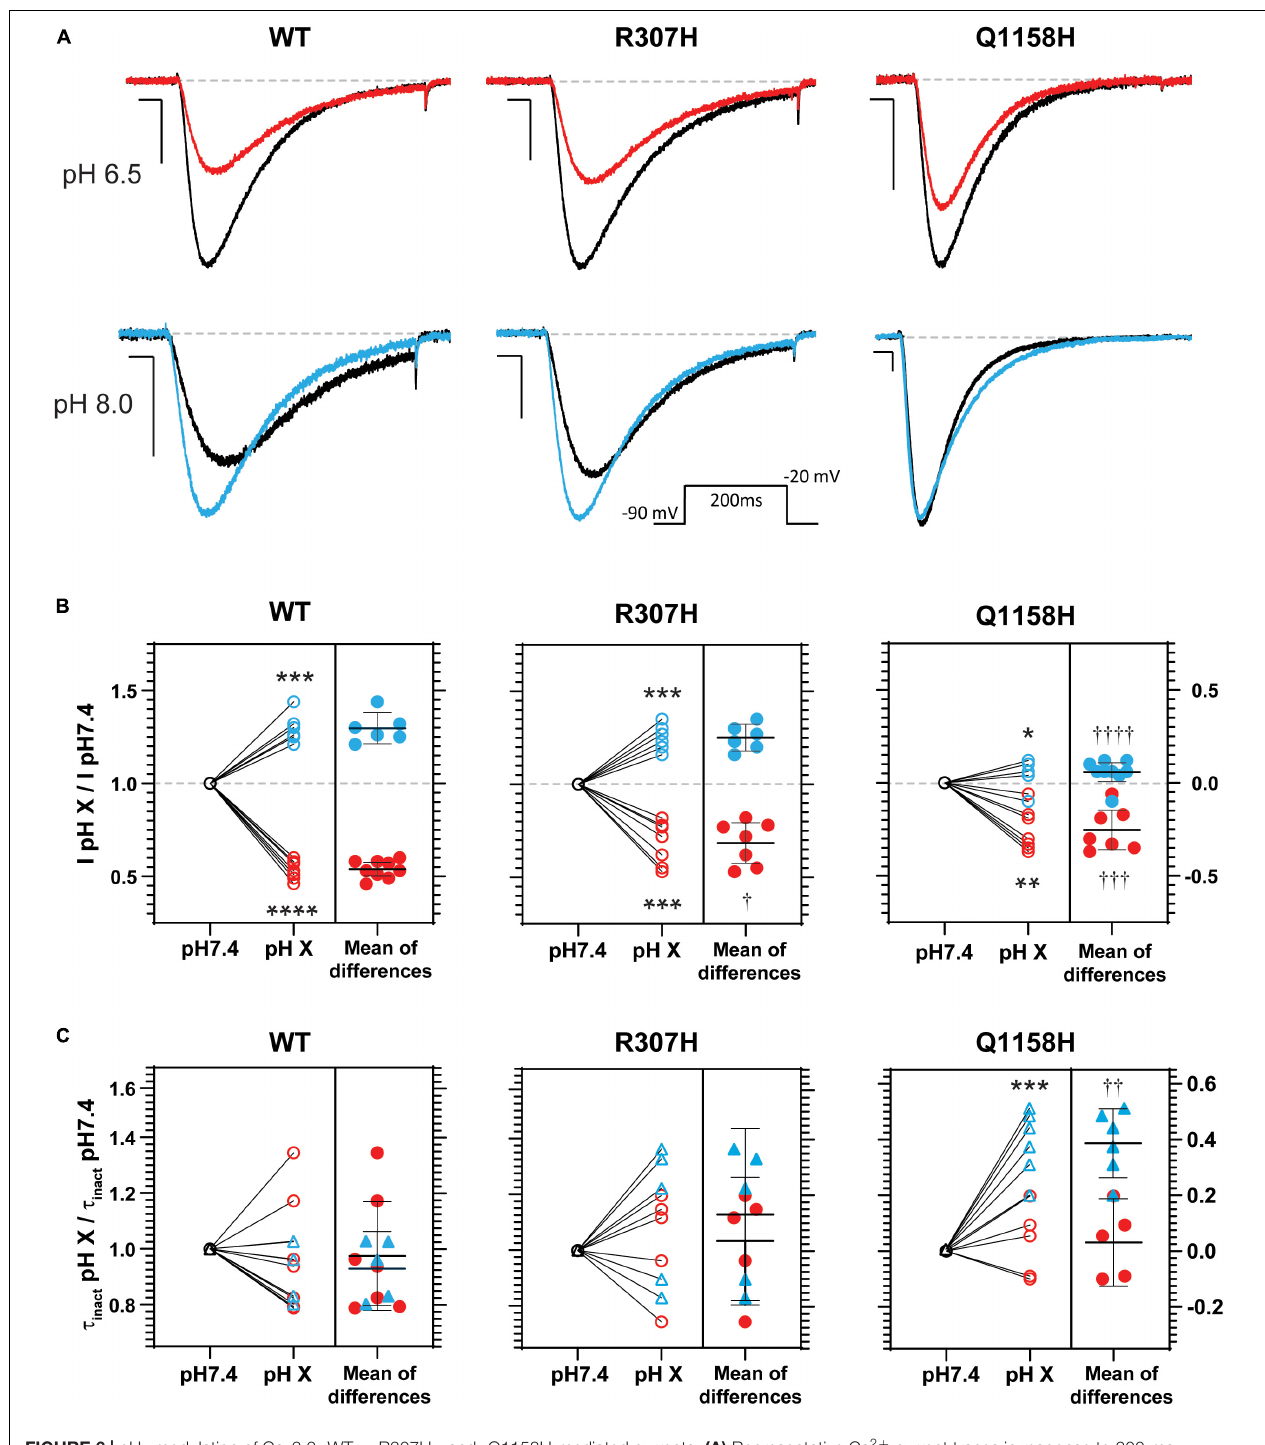
FIGURE 6 | pH o modulation of Cav3.3- WT-, - R307H-, and -Q1158H-mediated currents. (A) Representative Ca 2 + current traces in response to 200-ms depolarizing pulses to − 20 mV ( V h = − 90 mV, 0.1 Hz, inset) recorded in control (black, pH 7.4), acidic (red, pH 6.5), or alkaline (blue, pH 8.0) pH o conditions. Scale bars: 10 ms, 200 pA. Dashed line indicates zero level. (B) Relative change in peak current amplitude (I pH X/ I pH7.4) for WT and HM-associated Cav3.3 variants (pH 7.4: (cid:13) ; pH 6.5: (cid:13) ; pH 8.0: (cid:13) ; difference between pH